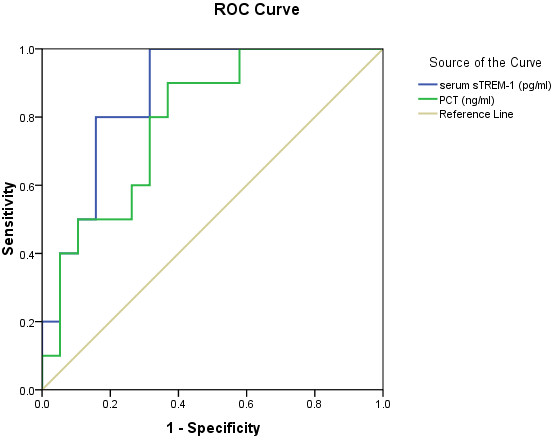
ROC curves for nonsurvivors versus blood culture-positives. Shown are the ROC curves for sTREM-1 and PCT for distinguishing nonsurvivors from blood culture-positives